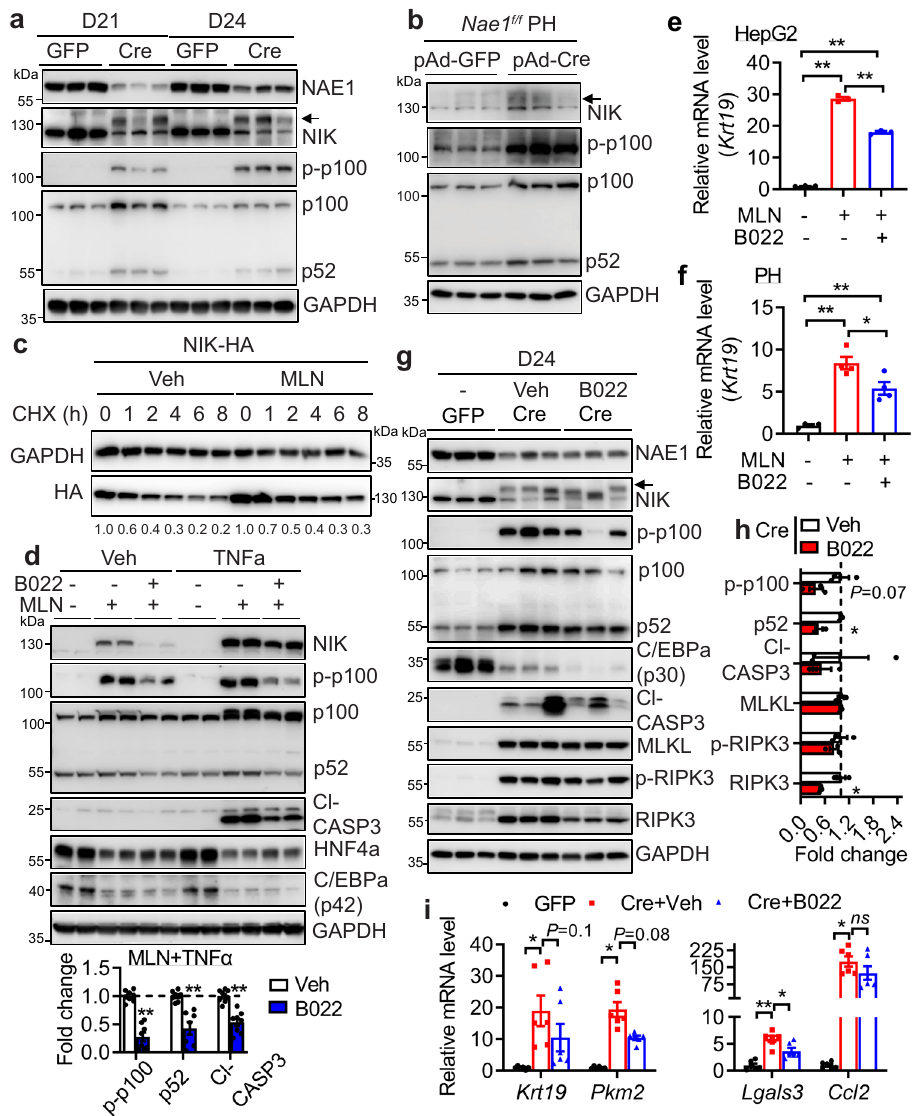
Fig. 6 | Neddylation de fi ciency elevates NIK which contributes to hepatocyte damage.a WesternblotinwholeliverextractsofAAV-GFP(GFP)andAAV-Cre(Cre) miceatD21andD24post-virusinjections( n =6pergroup). b Immunoblotanalyses in mouse Nae1 f/f primary hepatocytes (PH) 48h after infection with pAd-GFP and pAd-Cre ( n =3 per group). Arrow indicates the expected murine NIK. c Eighteen hoursaftertransfectionwithNIK-HA,HepG2cellsweretreatedwithvehicle(Veh)or 1.0 µ M MLN for 12h before 20 µ g/ml CHX treatment for indicated periods. d Western blot and quanti fi cations in HepG2 cells treated with Veh, 1.0 µ M MLN with or without 5 µ M B022 for 48h. 20ng/mL TNF α was added in the last 24h. Cleaved caspase-3 and NIK signaling were quanti fi ed by normalizing to cells receiving MLN and TNF α ( n =5 per group). Veh (black), B022 (blue). Multiple unpaired t -tests with the Holm-Sidak method. e , f qRT-PCR analyses in ( e ) HepG2 cells ( n =3 per group) and ( f ) wild-type primary hepatocytes ( n =4 per